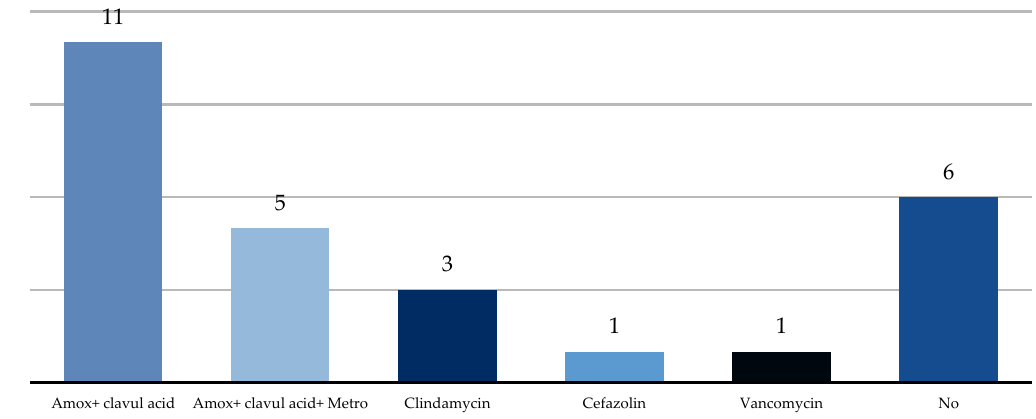
Figure 11. Correlation of CRP with length of hospital stay in lower face.